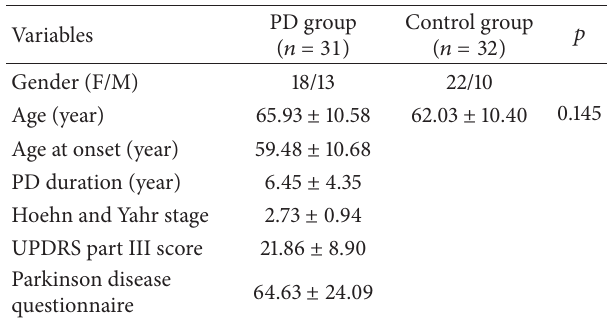
Table 2: Demographic and clinical characteristics of PD patients with median neuropathy versus without median